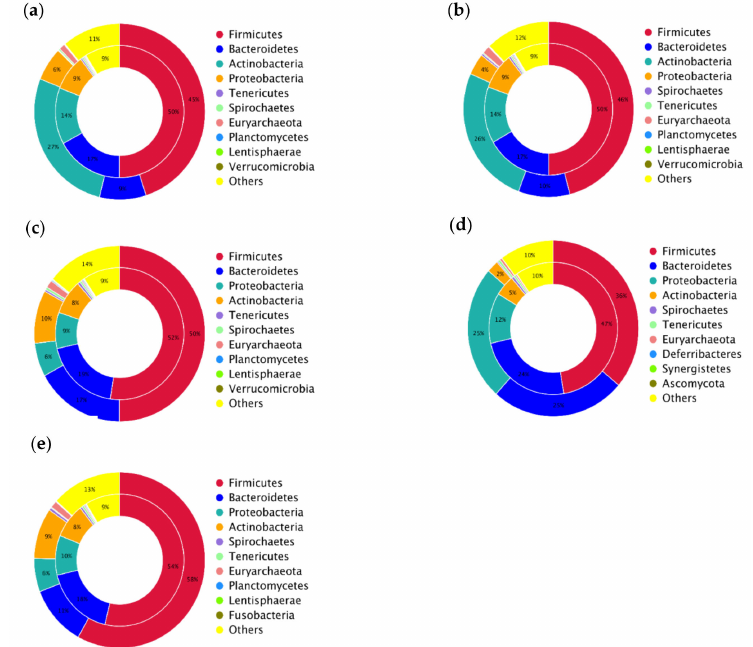
Figure 7. The attribution analysis of ARGs and the bacteria species in BB ( a ), GS ( b ), FS ( c ), WP ( d ), and FP ( e ) bioaerosols are showed by the circle maps. The inner circle shows the distribution of the bacteria species of the total ARGs, and the outer circle shows the species distribution of all samples. BB, GS, FS, WP, and FP refer to the bioaerosols collected from the piggeries that were exclusively